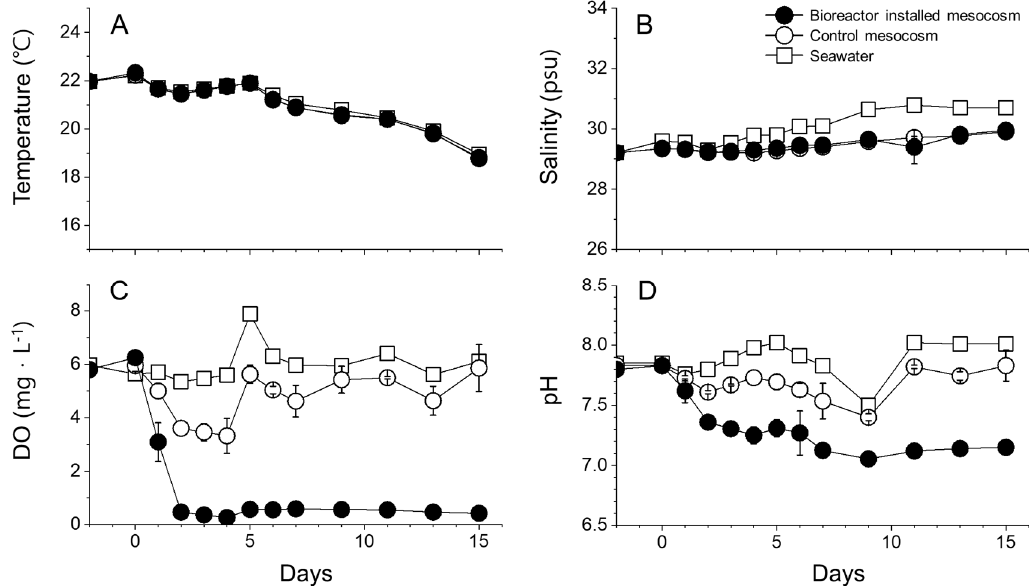
Figure 5. Changes in environmental factors: water temperature ( A ), salinity ( B ), dissolved oxygen ( C ), and pH ( D ) of each mesocosm and near seawater during mesocosm experiment period (15 days). Each value of white and dark circles was averaged using two measured values of the two bioreactor installed mesocosms or control mesocosms, respectively, but values of white squares were measured one time.